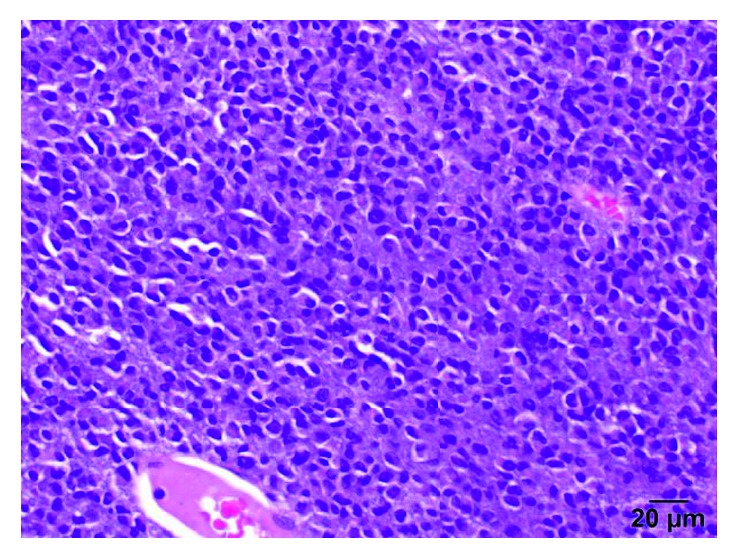
Liver biopsy (H&E).